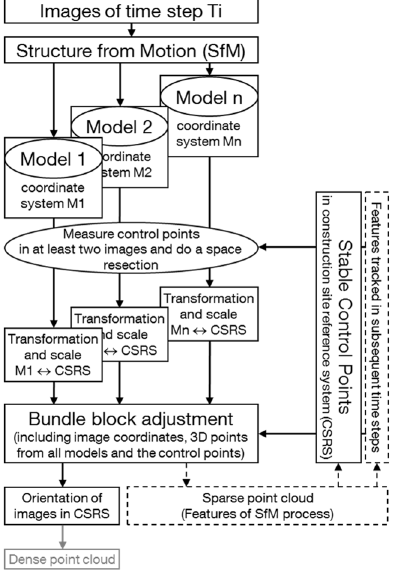
Figure 1. Procedure for image orientation